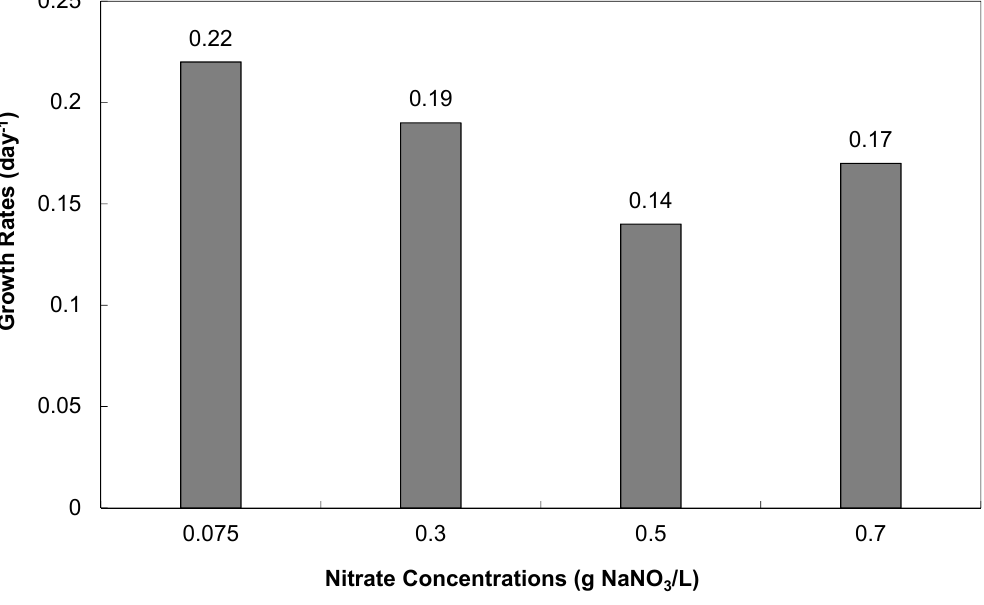
Figure 9. The effect of nitrate concentration on growth rates (µ) of P. cruentum